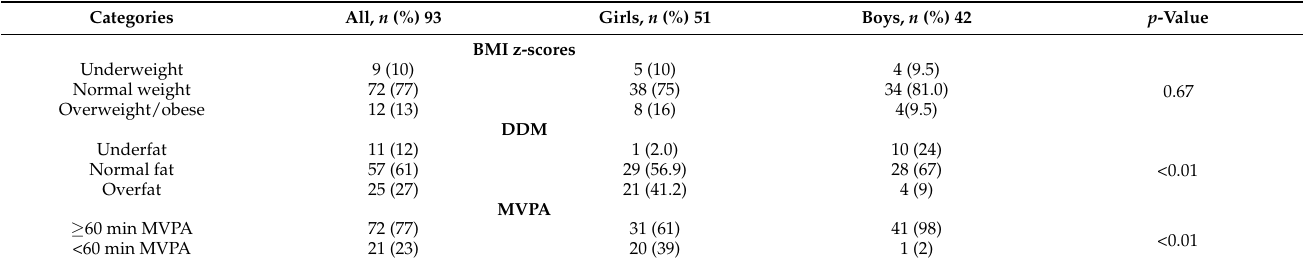
Table 2. Prevalence of weight and physical activity categories.